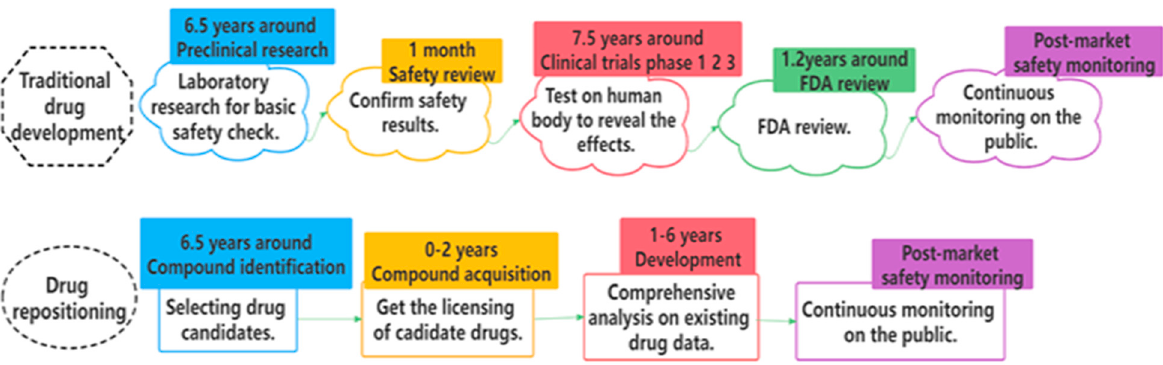
Figure 1. Two flowcharts on comparisons between traditional drug development and drug reposi- tioning.